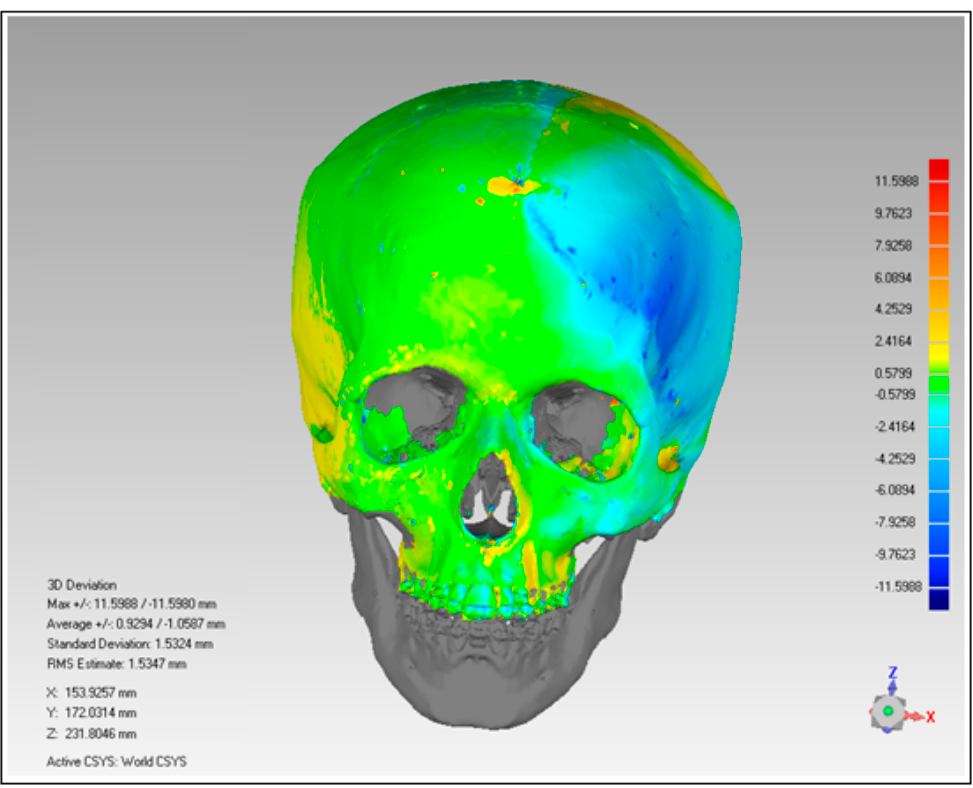
Figure 13. Outcome from 3D comparison analysis.